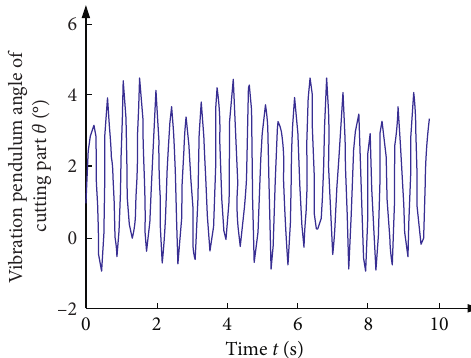
Figure 4: Vertical vibration swing angle of cutting part.